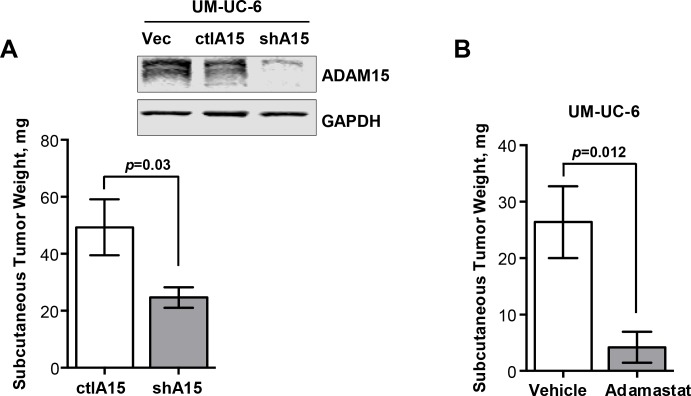
In vivo inhibition of ADAM15 activity reduces tumor growth.A) ADAM15 immunoblot of UM-UC-6 bladder cancer cells expressing empty vector (Vec), control scrambled ADAM15 sequences (ctlA15UC6) and short hairpin RNA (shRNA) sequence (shA15UC6). GAPDH was utilized as loading control (top). Subcutaneous inoculation of shA15UC6 cells (n = 10) in SCID mice led to decreased tumor weight compared to ctlA15UC6 control cells (n = 10) (bottom). B) UM-UC-6 cells were subcutaneously implanted in SCID mice. Specific inhibition of the ADAM15 catalytic activity by daily treatment with adamastat 100 mg/kg (n = 5) during 3 weeks led to decrease in tumor growth compared to vehicle treated mice (n = 5). Bars represent mean tumor weight (mg) ± SD (5A,B).